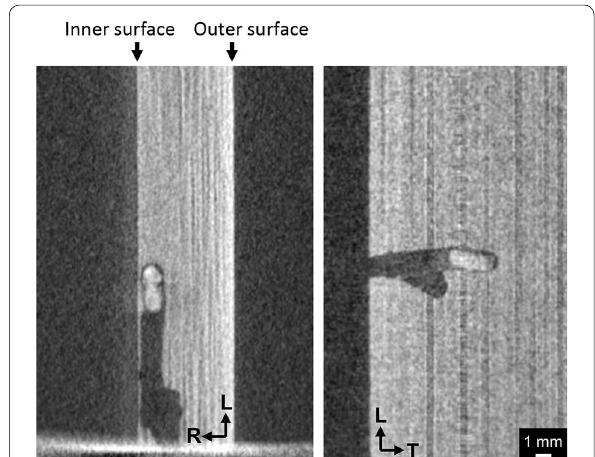
Fig. 11 CT images of tunnels of mated males, obtained using low magnification scans. Left tunnel of individual M1 bored longitudinally, right tunnel of individual M5, bored almost transversely to the fiber direction, with a branched oblique tunnel. Note that, on the left image, metal artifacts caused by the AE sensor are significantly visible at the